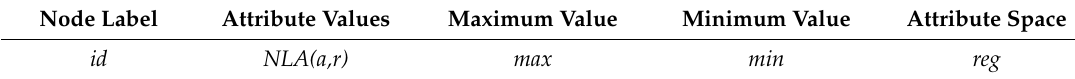
Table 1. The format of qdata .